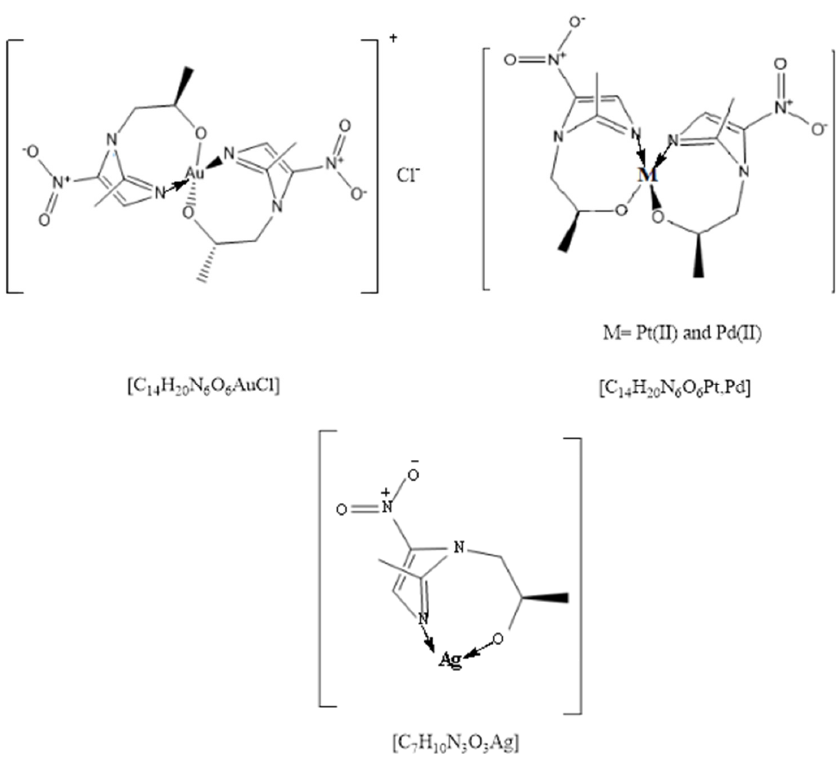
Figure 1. Proposed structure of the new synthesized